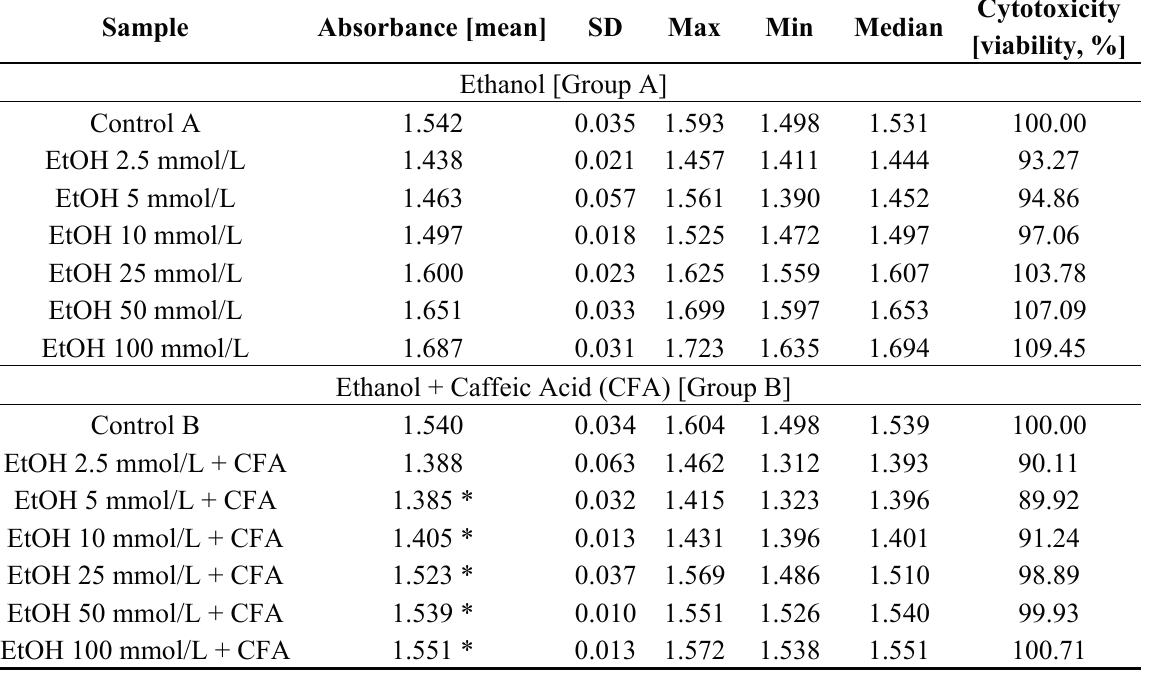
Table 1. Descriptive statistics for absorbance measurements. MTT (3-[4,5- dimethylthiazol-2-yl]-2,5-dimethyltetrazolium bromide) cytotoxicity assay [ethanol concentrations units—mmol/L]. Sample Absorbance